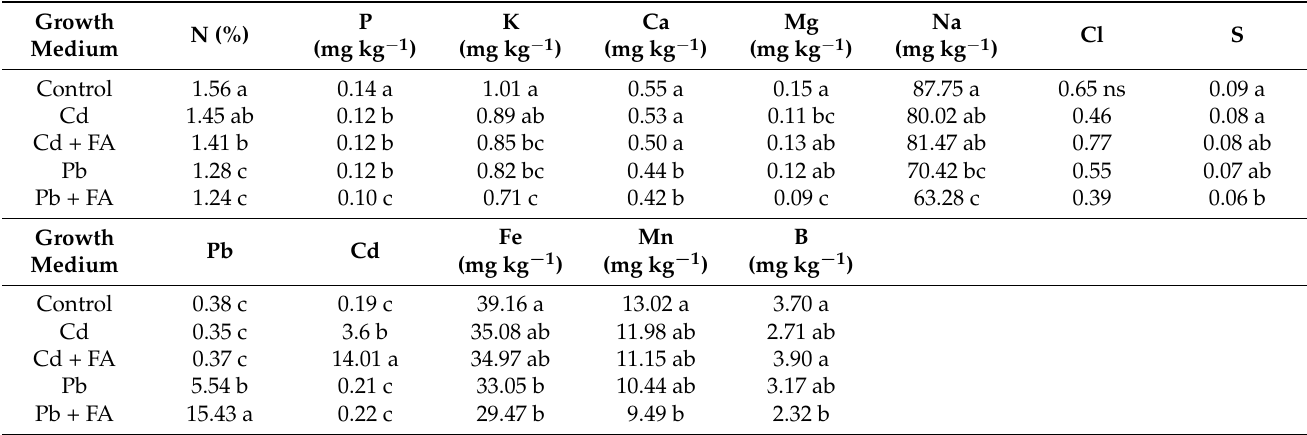
Table 4. The shoot part macro and micro element analysis results of Tagetes eracta